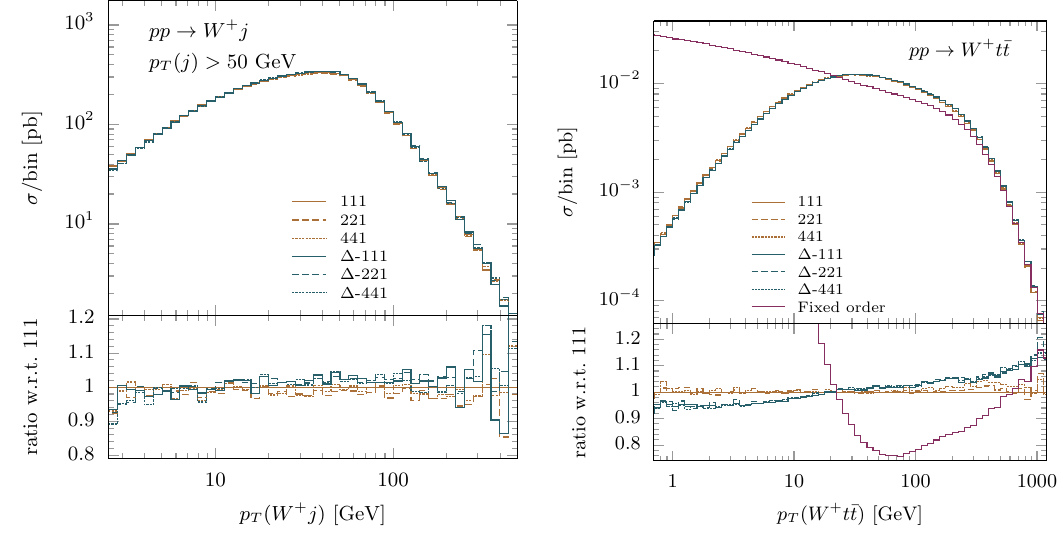
Figure 4 . As in (cid:12)gure 2, for the transverse momentum of the W -hardest jet system (left panel) and of the W + t (cid:22) t system (right panel), for the processes in eqs. (5.11) and (5.12), respectively. In the right panel, the (cid:12)xed-order result (red solid) is also